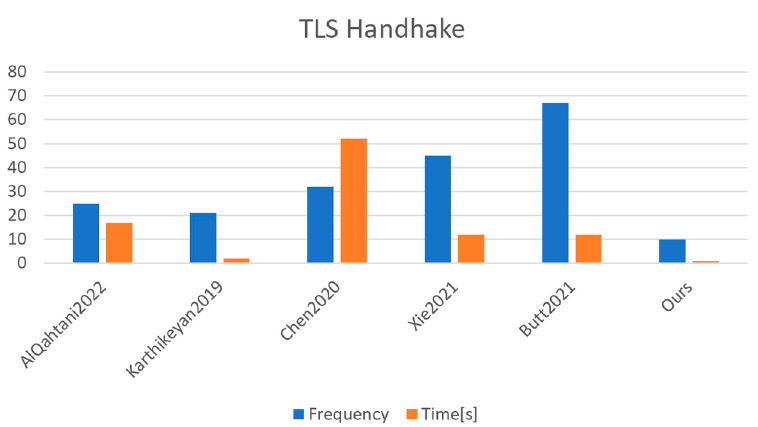
Figure 4. Execution time of the TLS handshake using the MICAz sensor. References: AlQah-